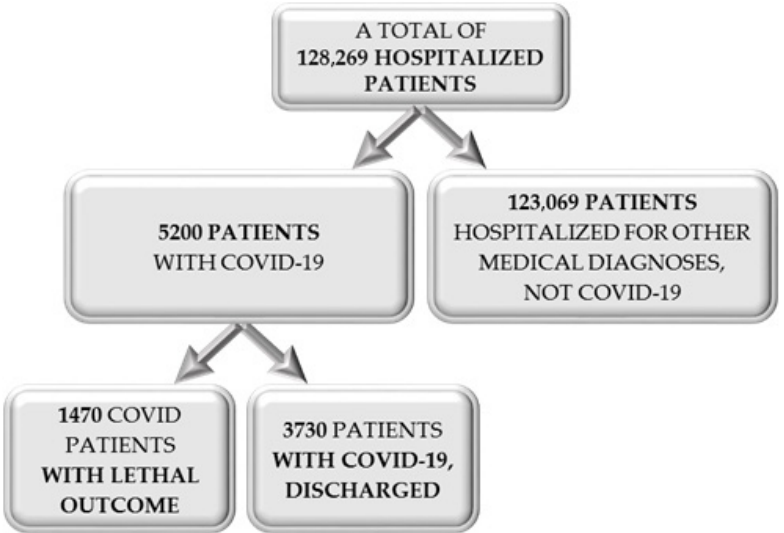
Figure 1. Flow chart of the participants’